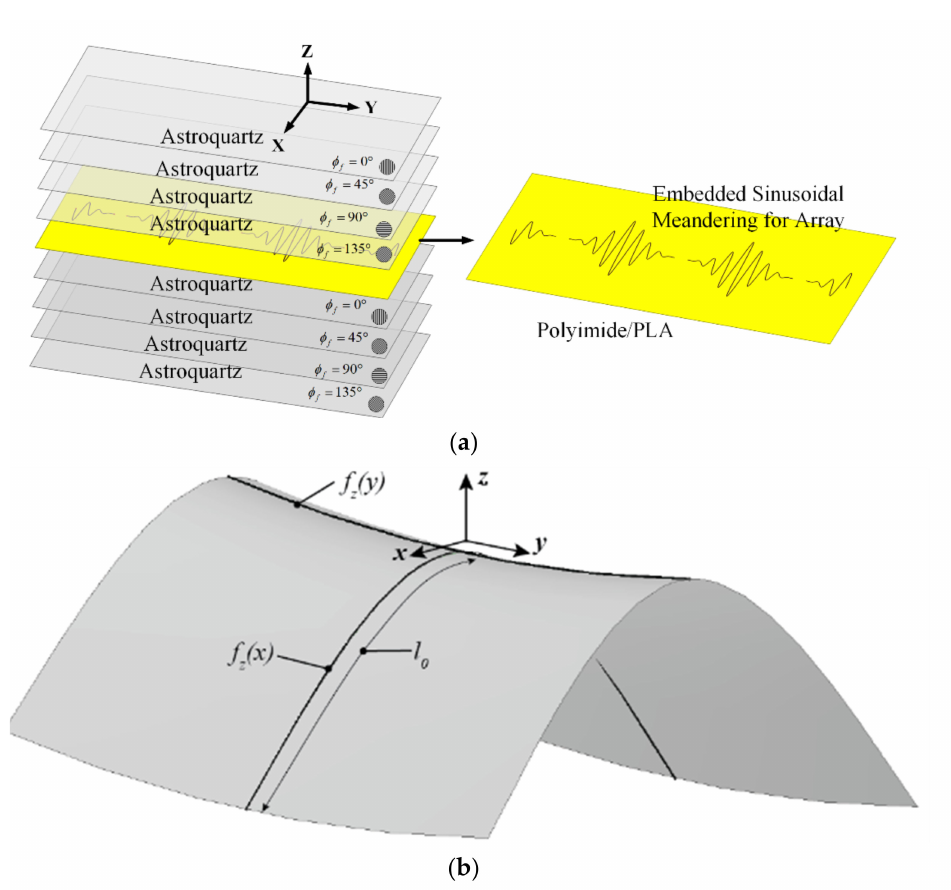
Figure 2. Detailed representation of multi-element SEVA conformal linear array (SEVA-CLA) ( a ) Fabrication lay-up ( b ) CAD model of complex curved mandrel used for shaping the